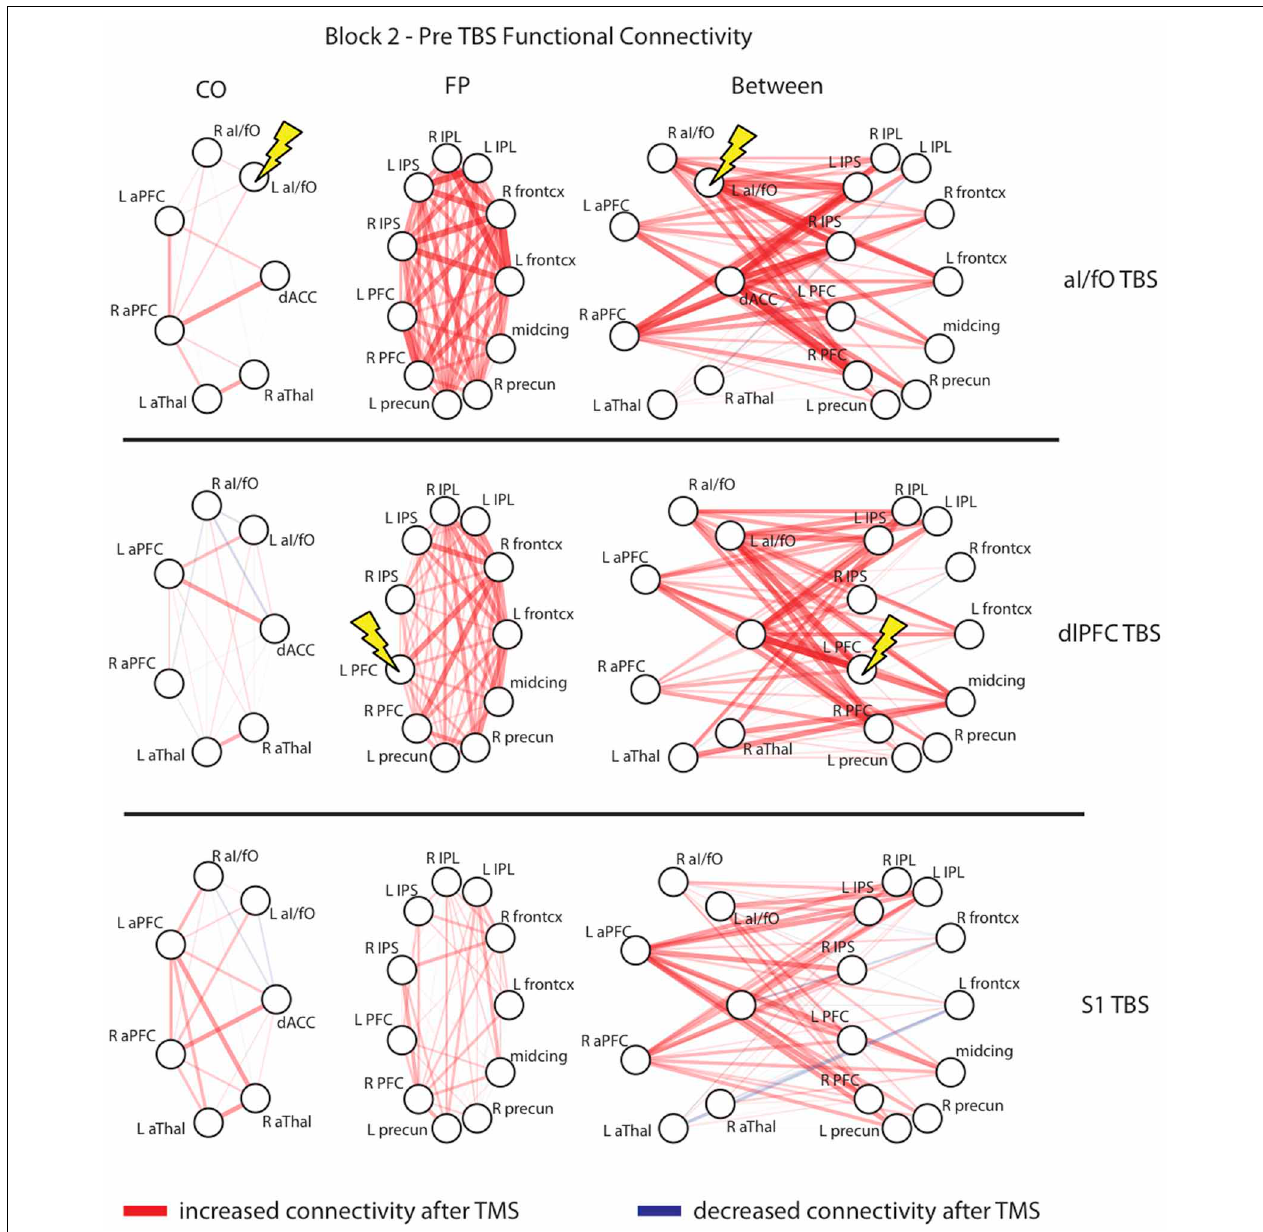
FIGURE 4 | Network interactions after TBS. Connectivity changes in the second block after TBS are shown for each individual connection with the CO network ( Left column ), the FP network ( Middle column ), and between the two networks ( Right column ) after TBS to the L aI/fO ( Top row ), L dlPFC ( Middle row ), and L S1 ( Bottom row ). As can be seen, TBS generally